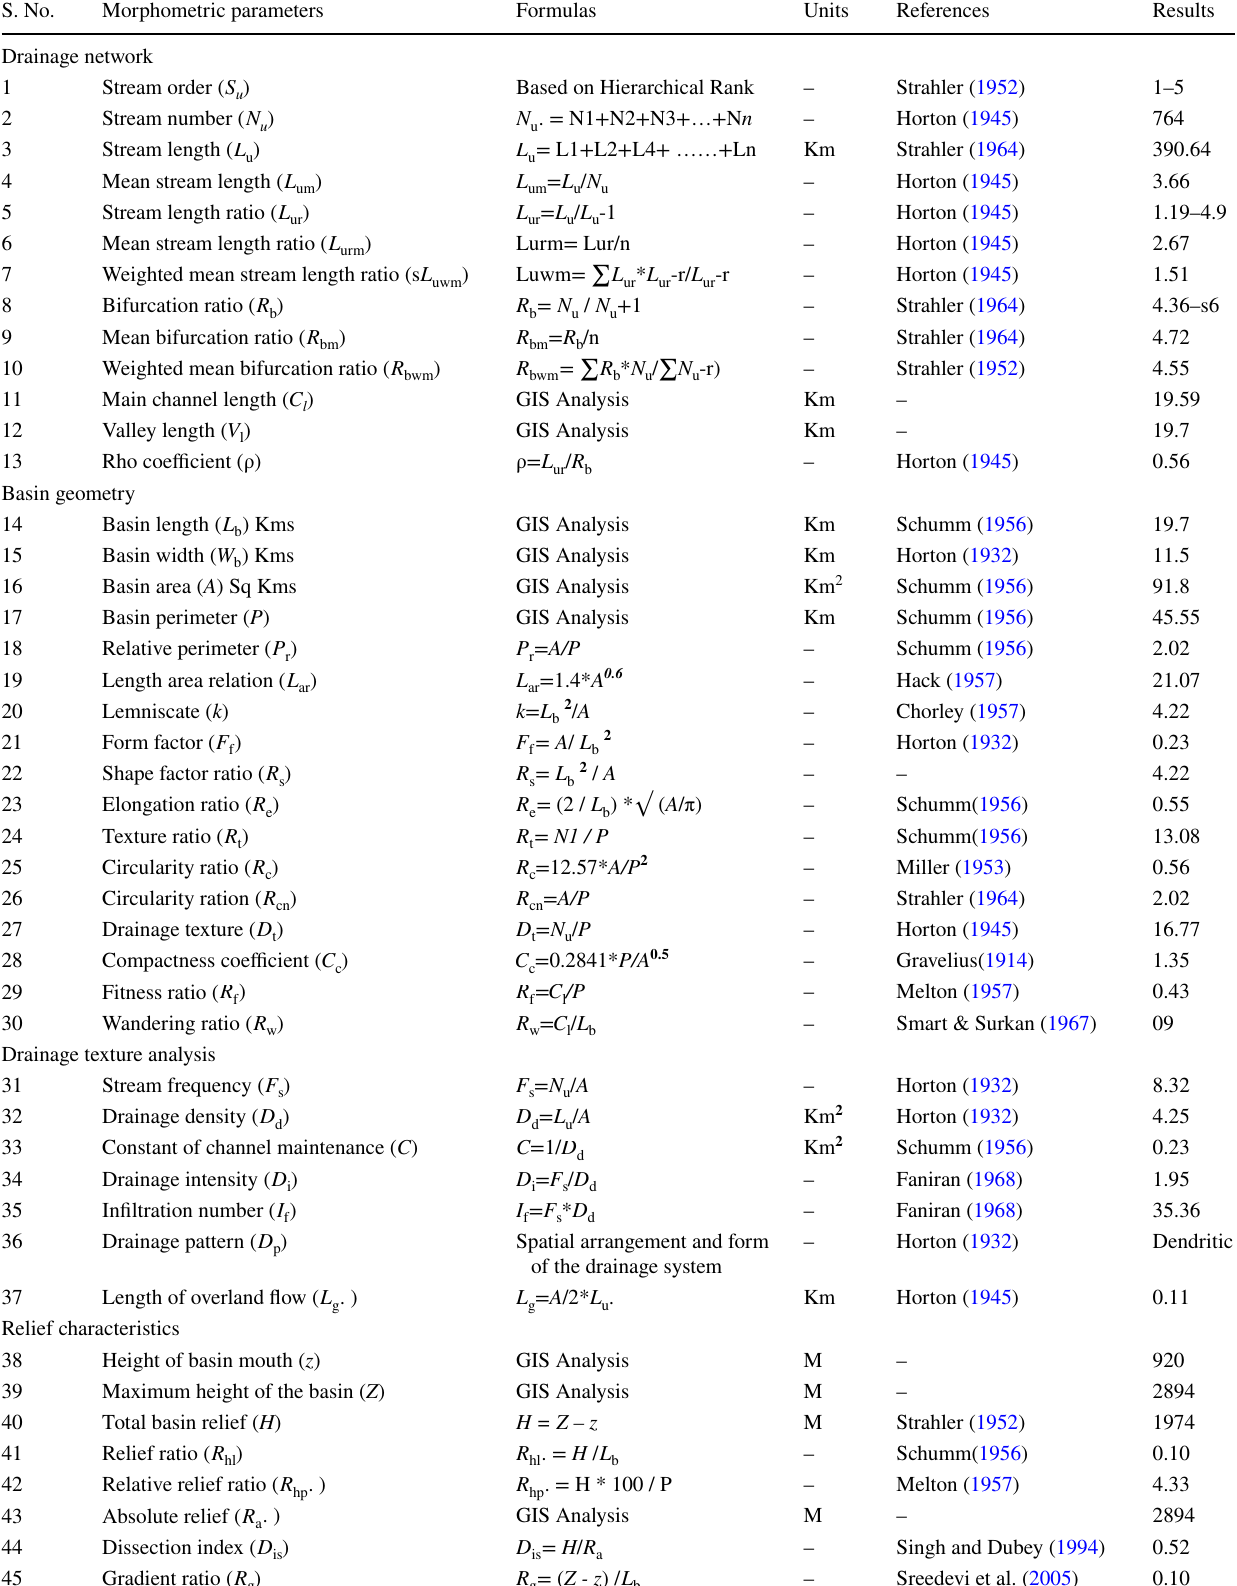
Table 2 Results of various morphometric parameters for the Dhanari watershed S.